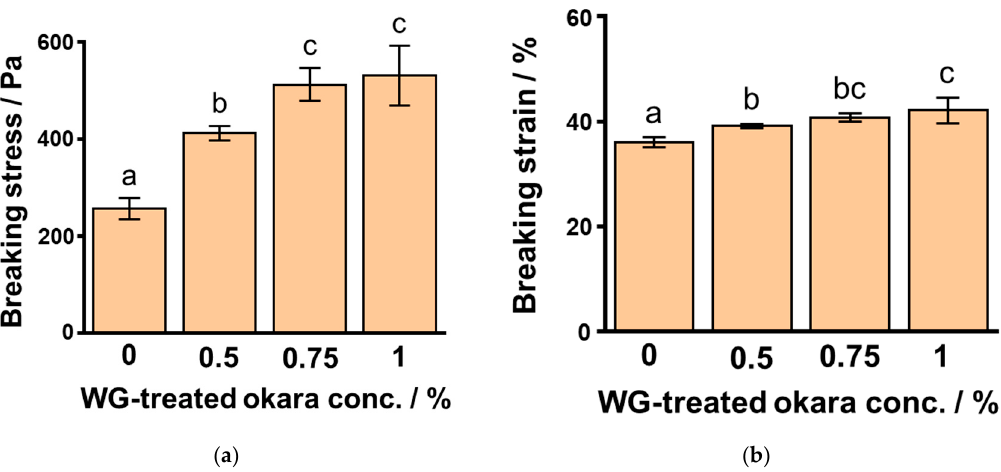
Figure 5. The breaking stress ( a ) and strain ( b ) of 6% soybean protein isolate (SPI) gels at 1.0% NaCl with the addition of five-time wet-type grinder-treated okara at different concentrations. Different letters indicate significant differences ( p < 0.01).